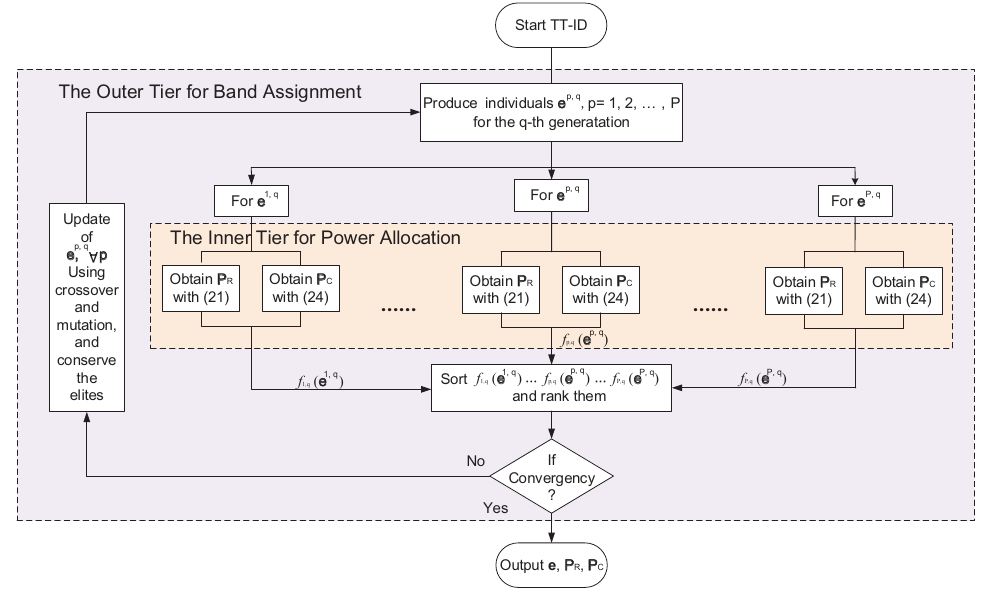
Figure 3. The flowchart of TT-ID algorithm. Algorithm 1 Bisection search of ϑ .